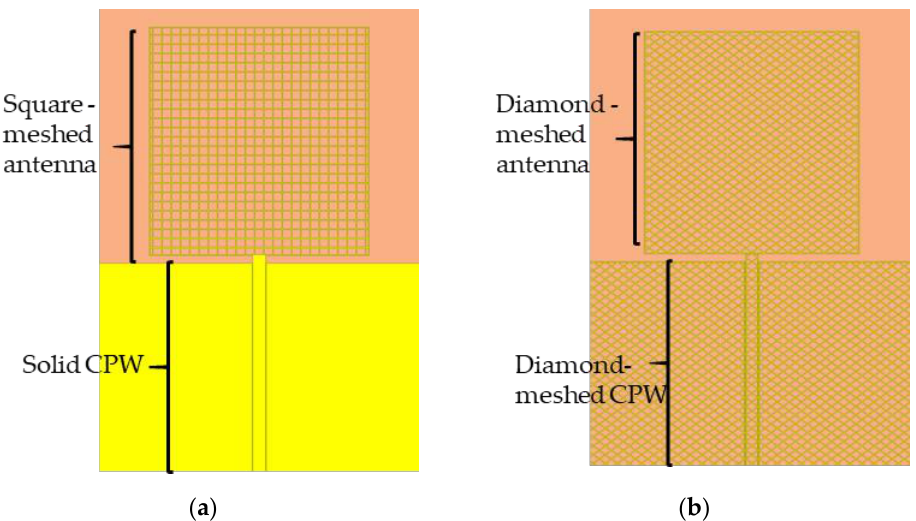
Figure 8. Meshed antenna: ( a ) square-meshed antenna without meshed feedline; ( b ) diamond- meshed antenna with meshed feedline.